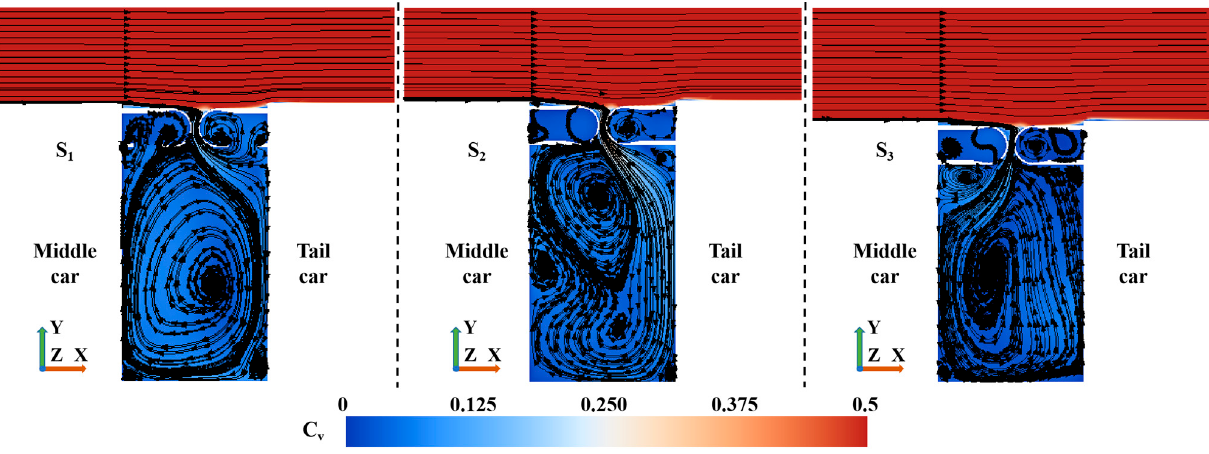
Figure 10. Average flow-field structure of the cross-section under the initial flow-field state.